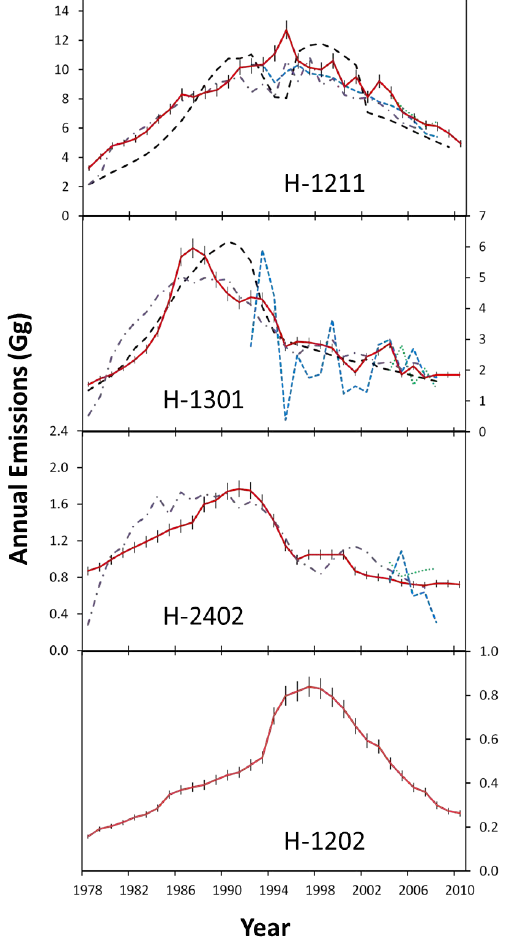
Fig. 2. Model-derived global annual emissions (Gg) of the halons. Current work – red line; NOAA one-box model (Montzka et al., 2011) – blue short dashed line; AGAGE one-box model (Montzka et al., 2011) – green dotted line; AGAGE 12-box model (Montzka et al., 2011) – purple dash-dot line; annual emissions reported by HTOC (2011) – black long dashed line. Uncertainty ranges, as de- fined in Sect. 4, are shown for each